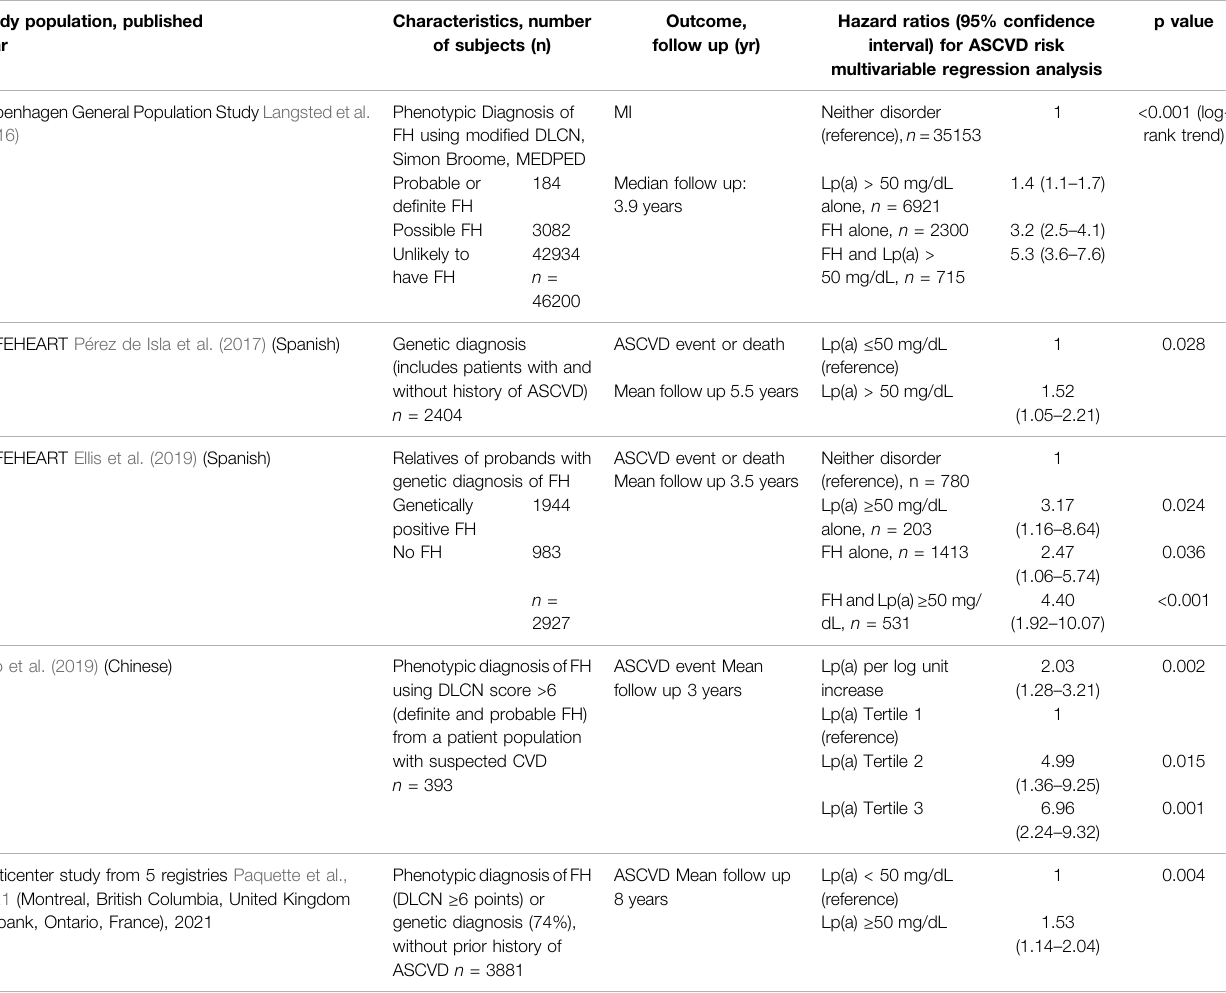
TABLE 1 | Selected prospective studies in familial hypercholesterolemia showing the association between lipoprotein(a) levels and atherosclerotic cardiovascular disease risk. Study population, published